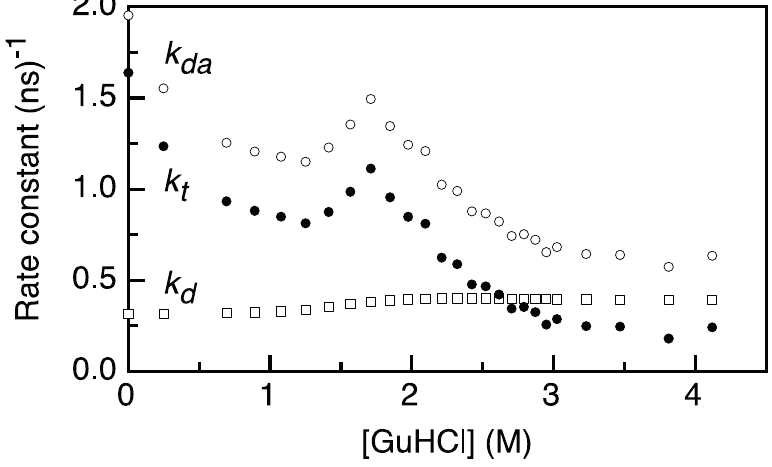
Figure 3. The rate constants of energy transfer change as a function of denaturant concentration. Rate constants are obtained through the relation k i = 1/ τ i . k da is the decay rate of the donor fluorescence in presence of an acceptor, as obtained from the acceptor rise time (open circles), k d is the decay rate of the donor in the absence of an acceptor (open squares) and is obtained from [8], as described in Supplementary Information SI2, and k t is the rate of energy transfer, as obtained from the relation k t = k da − k d (Equation (5); black